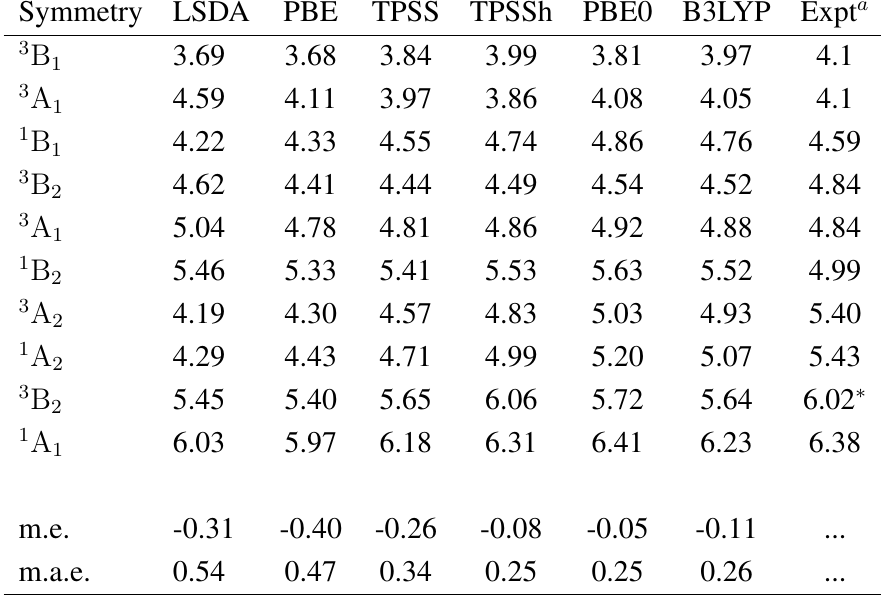
H N). The mean experimental value is 5 5